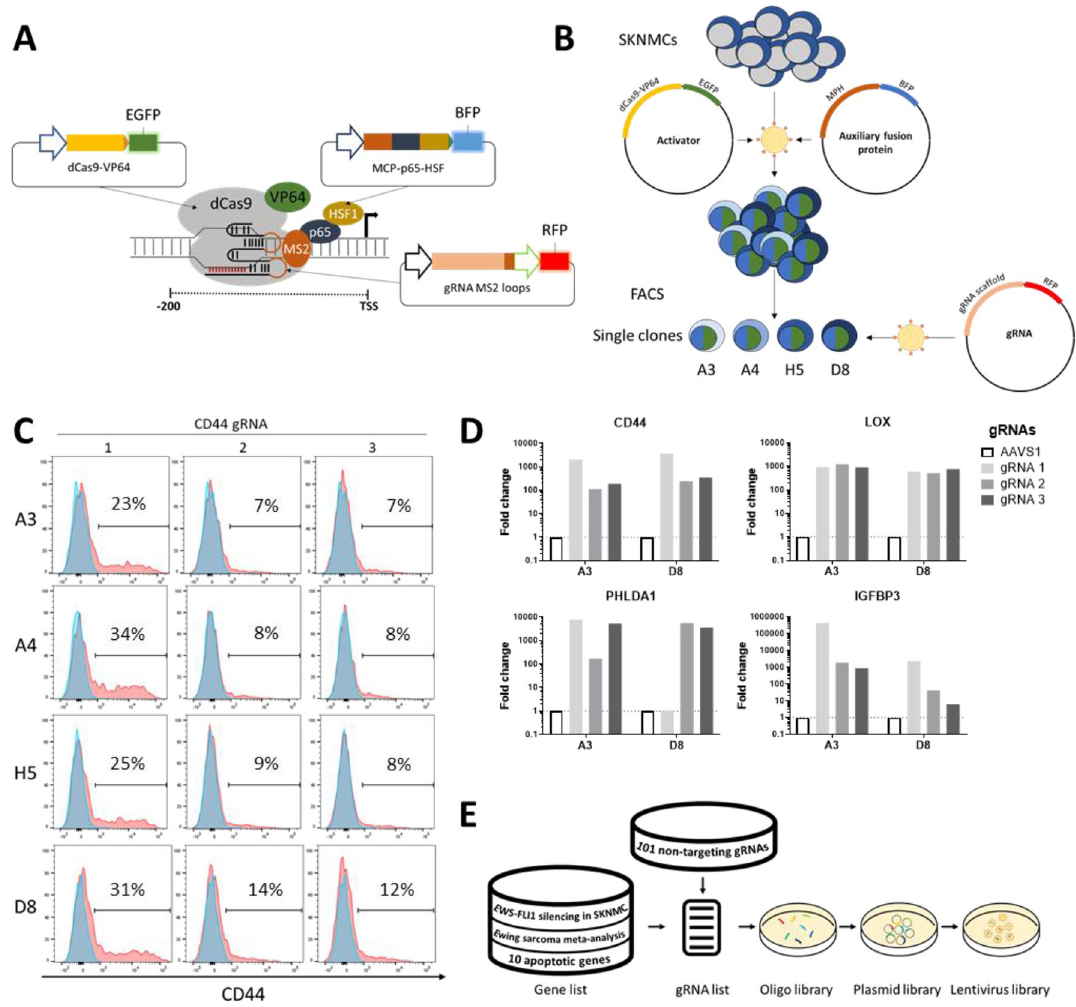
Figure 1. Establishment of the CRISPRa cell line. ( A ) Schematic representation of the modified CRISPRa Synergistic Activation Mediator (SAM) system (Based on 22). ( B ) Schematic representation of the clonal cell line generation. ( C ) Expression of the surface marker CD44 was measured by flow cytometry after introduction of CD44 targeting gRNAs. The percentage of positive cells for three gRNAs and four cell clones (A3, A4, H5 and D8) is indicated. Image was created by using FlowJo version 10, https:// www. flowjo. com. ( D ) mRNA expression of four repressed genes (CD44, LOX, PHLDA1, and IGFBP3) was measured by qRT-PCR after gRNA transduction in the clones A3 and D8. Data is indicated as fold change over non-targeting control guide AAVS1, normalized to GAPDH. Image was created by using GraphPad version 8, https:// www. graph pad. com. ( E ) Schematic representation of the gene selection for the lentiviral library